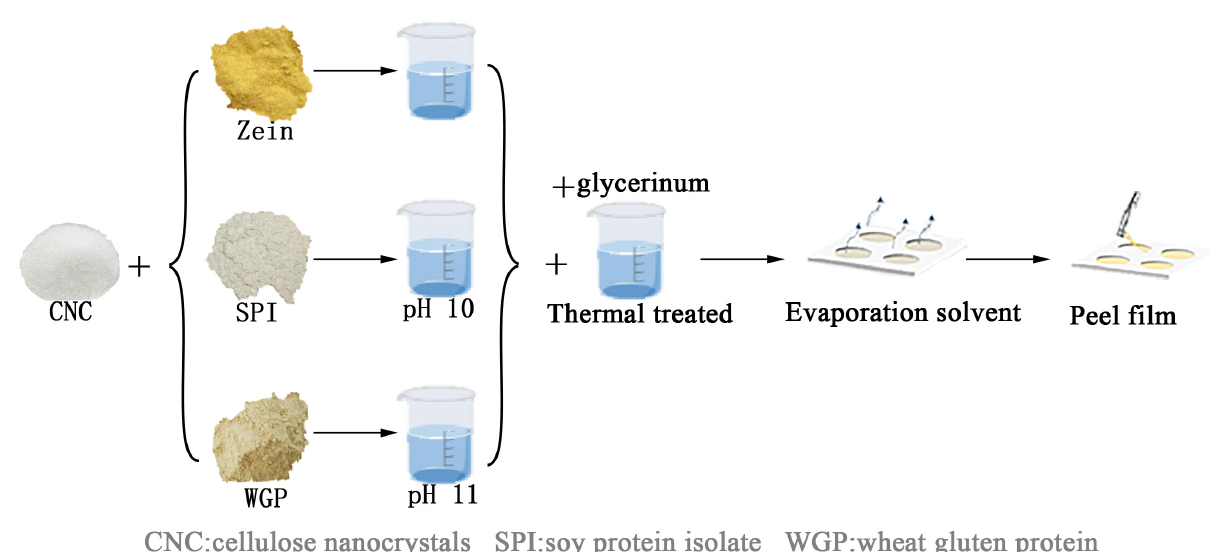
Figure 1. Schematic diagram of the preparation of the plant protein films.